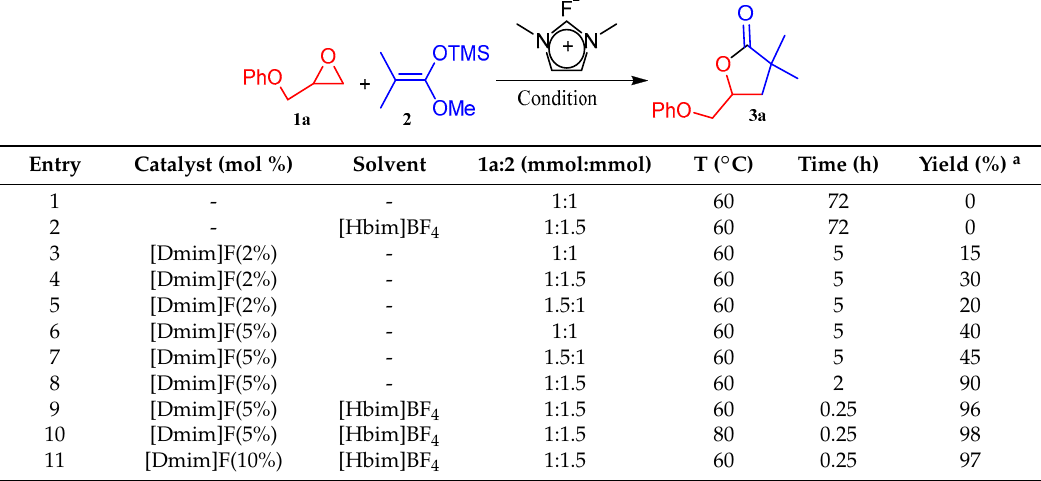
Figure 3. Retrosynthesis strategy for the synthesis of γ -butyrolactones. Table 1. Investigation of catalytic activity of [Dmim]F for the synthesis of γ -butyrolactones under various conditions.